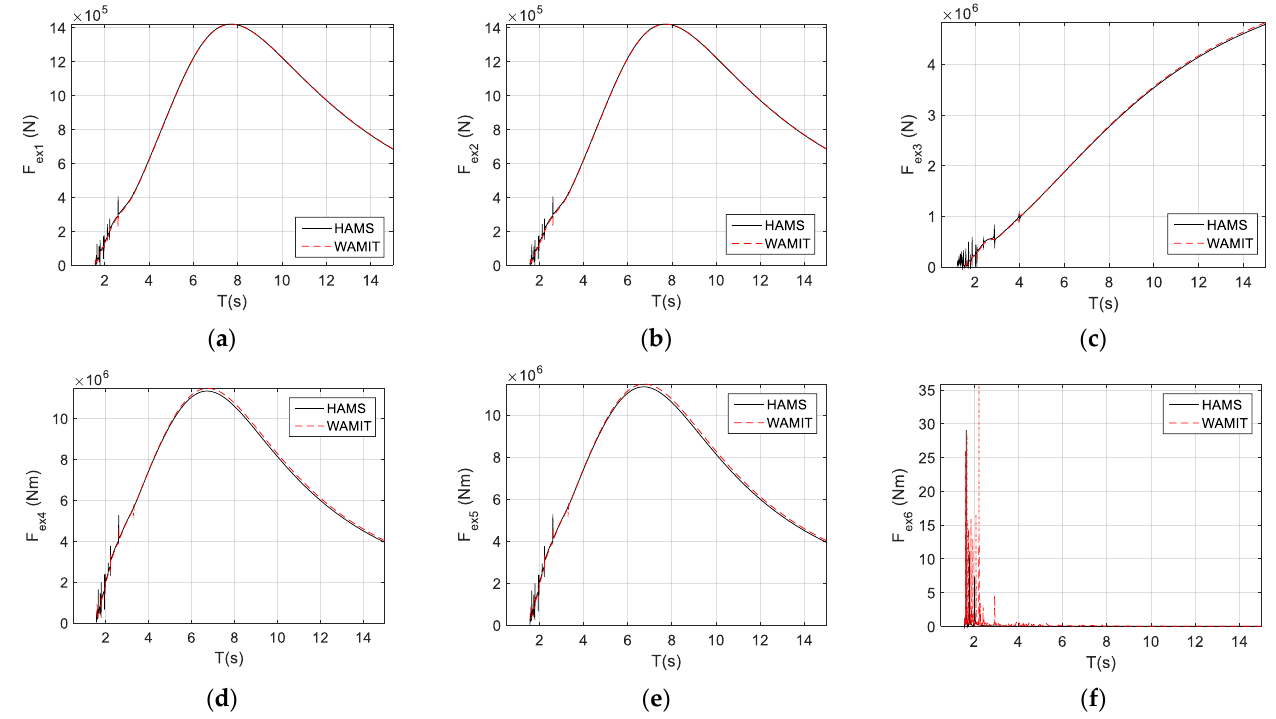
Figure 6. The wave-excitation forces on the TALOS structure (incoming wave angle = 45°). ( a ) Surge; ( b ) sway; ( c ) heave; ( d ) roll; ( e ) pitch; and ( f )